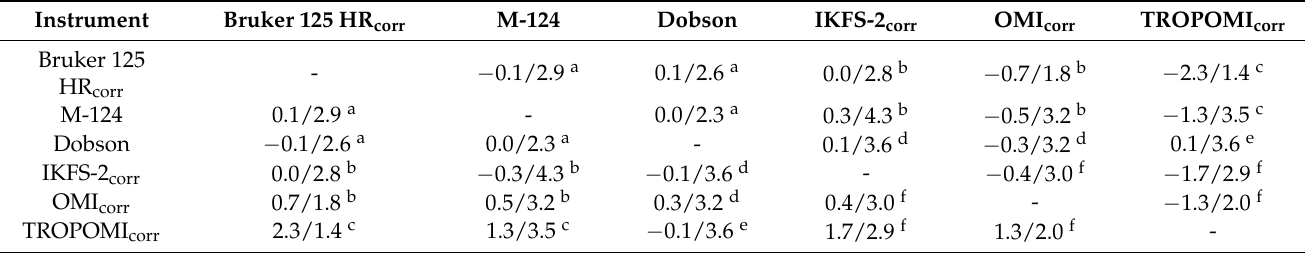
Table 5. Statistical characteristics of differences between corrected TOC observation data near St. Petersburg for several time spans in the 2004–2020 period. MD and SDD relatively to Dobson mean TOC are shown in %. Letters in cells depict different time spans in which the data are